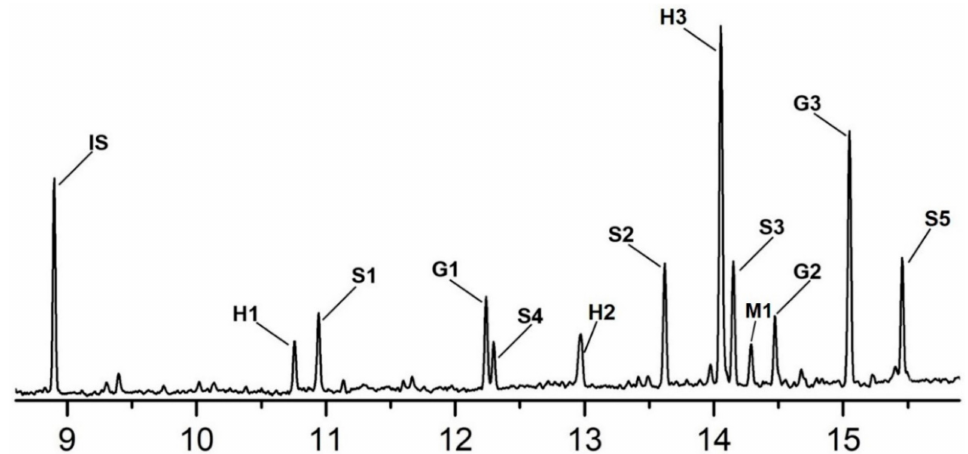
Figure 5. Total ion chromatogram and peak identification of the lignin monomers released from catalytic hydrogenolysis of bagasse lignin over Pd-Fe 3 O 4 (reaction condition from Scheme 1, M1 = monomer 1).